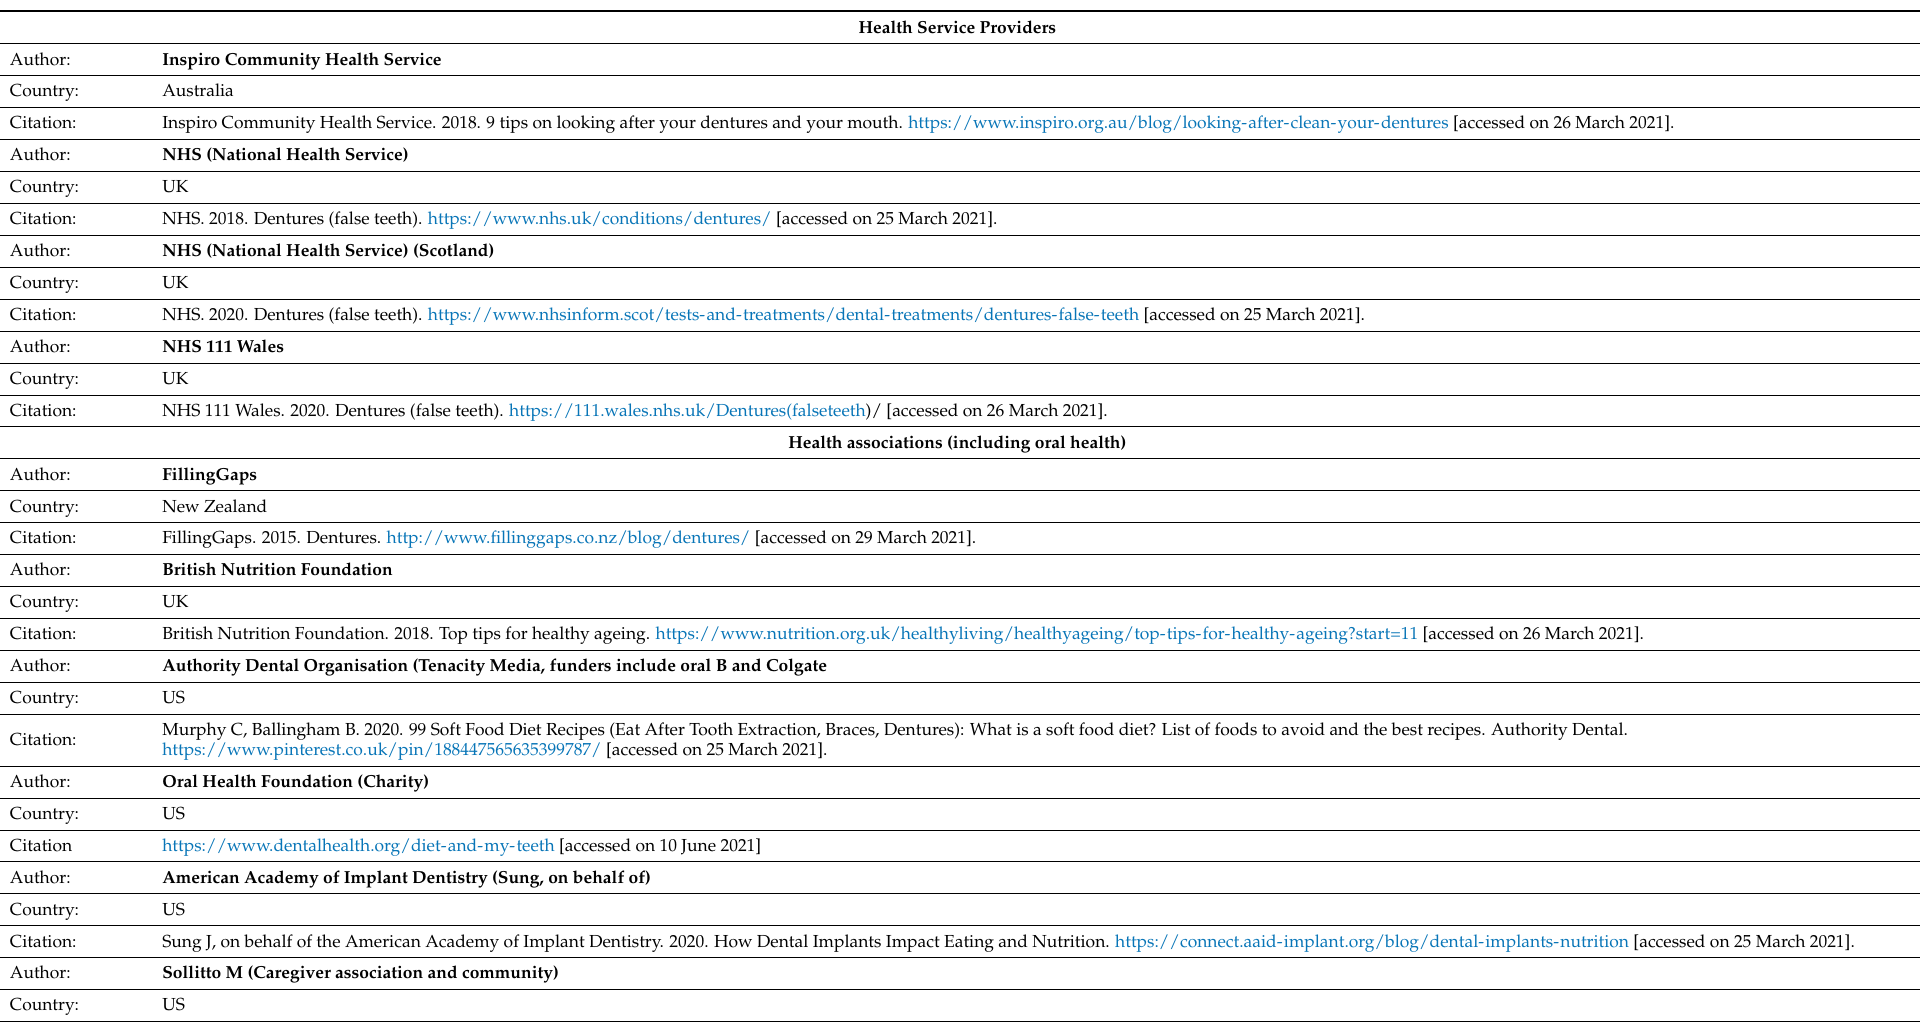
Table A3. List of included websites from which information was